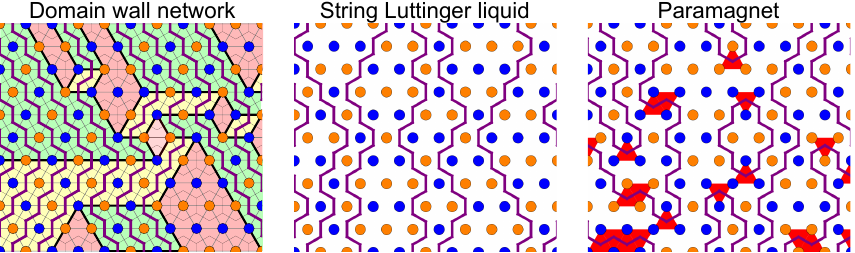
Figure 11: Correlations in the dipolar TLIAF. (a) Phase diagram showing the string density, n the three qualitatively different regimes of the disordered phase: a weakly-correlated paramagnet (PM), a strongly-correlated string Luttinger liquid and a strongly-correlated domain-wall network. (b) Within the string-Luttinger-liquid regime the correlation length, ξ , and Luttinger parameter, K , (see Eq. 18) can be determined at a given T and δ by fitting S ( q ) using Eq. 19. (c) The crossover from the string- Luttinger-liquid to the domain-wall-network regime is due to a change from repulsive to attractive string-string interactions. The temperature of this crossover can be approximately determined from simulating the average string separation, ∆ x (see Appendix E.4 for a definition of ∆ x ), in a system constrained to have exactly two strings.